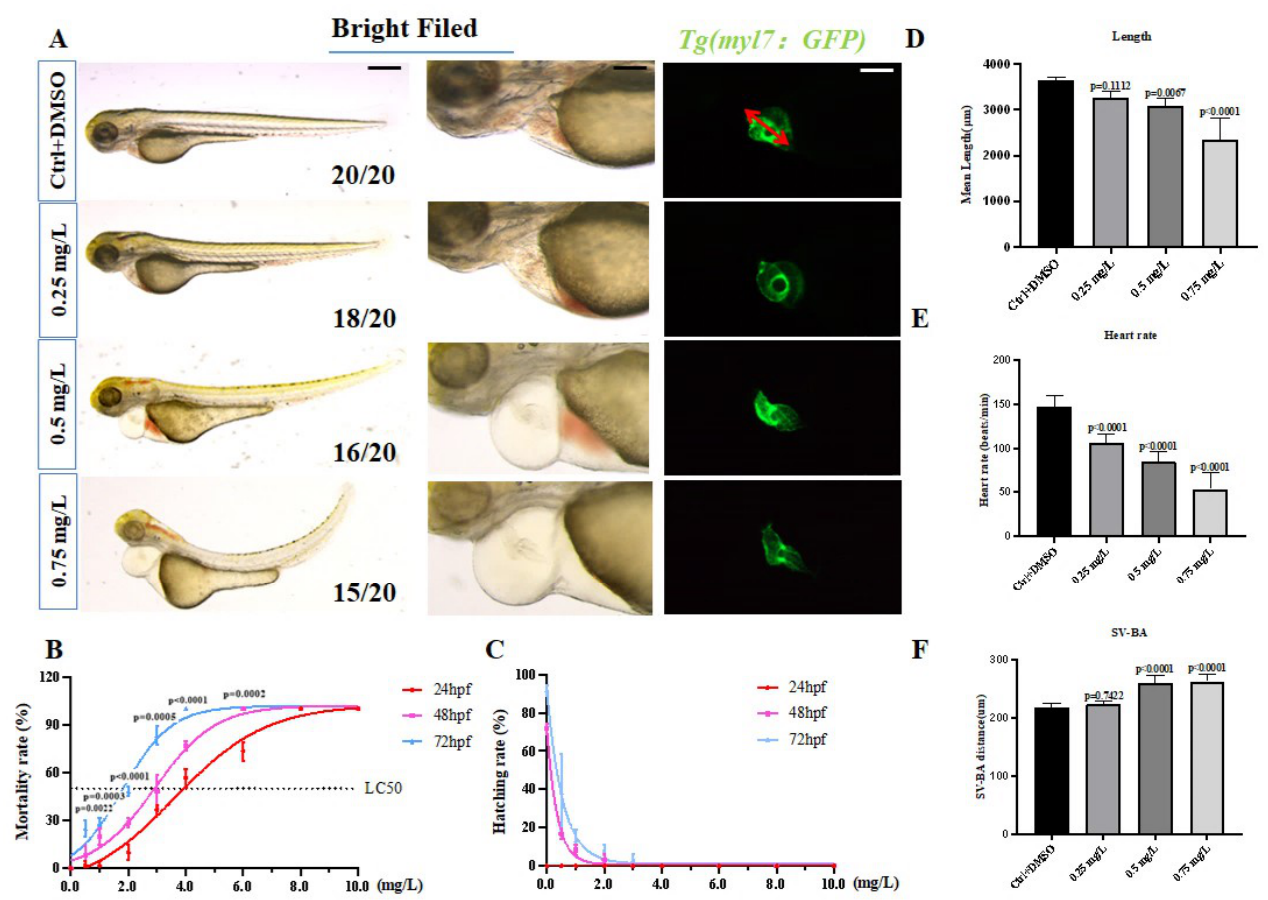
Figure 1. The phenotype of embryos treated with PBCN. ( A ). Bright field images of the whole body and heart and fluorescence microscope images of the heart. ( B , C ). Under different concentrations of PCNB, 24, 48, 72 hpf, the survival rate and hatching rate of embryos. ( D – F ). A statistical graph of the embryo’s body length, heart rate, and atrioventricular distance after 72 h of treatment with different concentrations. SV-BA refers to the distance from the atrium to the ventricle, the red arrow in the figure points. ( n = 3, Means ± SD. Scale bar: 500 µ m/100 µ